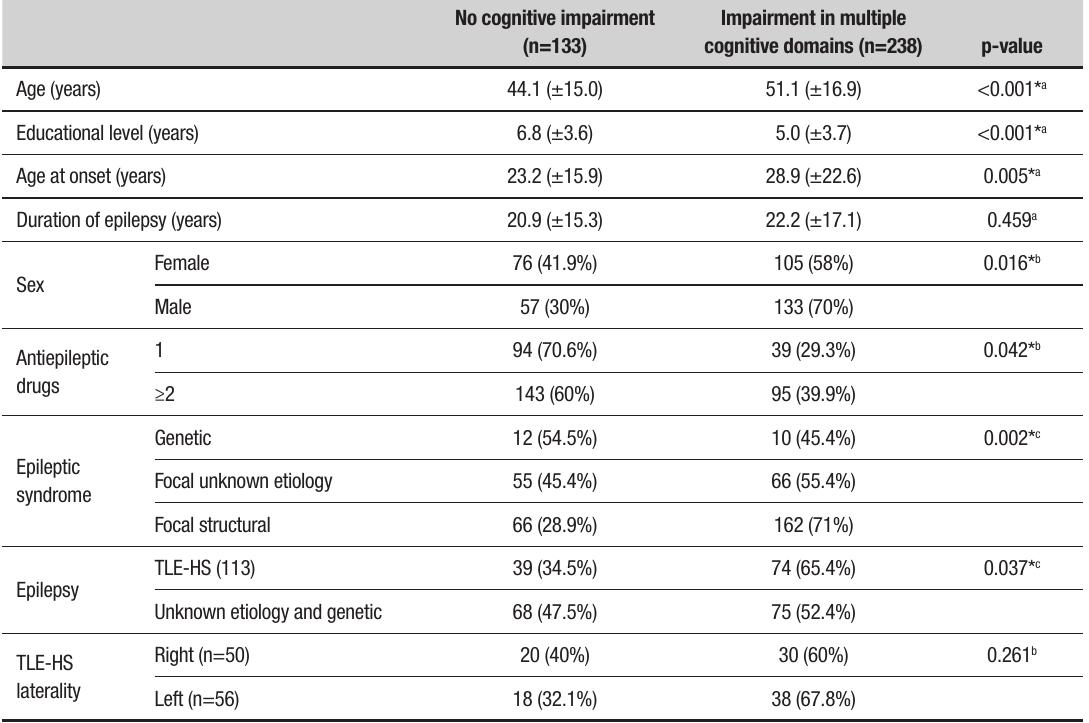
Table 3. Sociodemographic and clinical aspects according to occurrence of cognitive disorder.